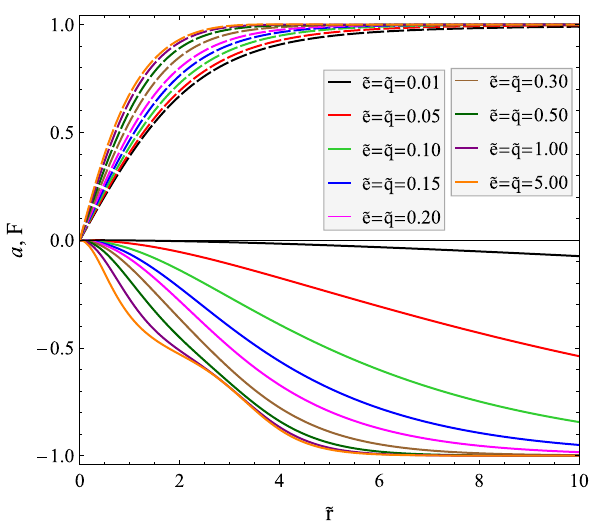
Fig. 6 Profile functions a (solid curves) and F (dashed curves) of the vortex-Q-ball system for different values of the gauge coupling constants. The parameters of the vortex-Q-ball system are the same as in Fig. 5